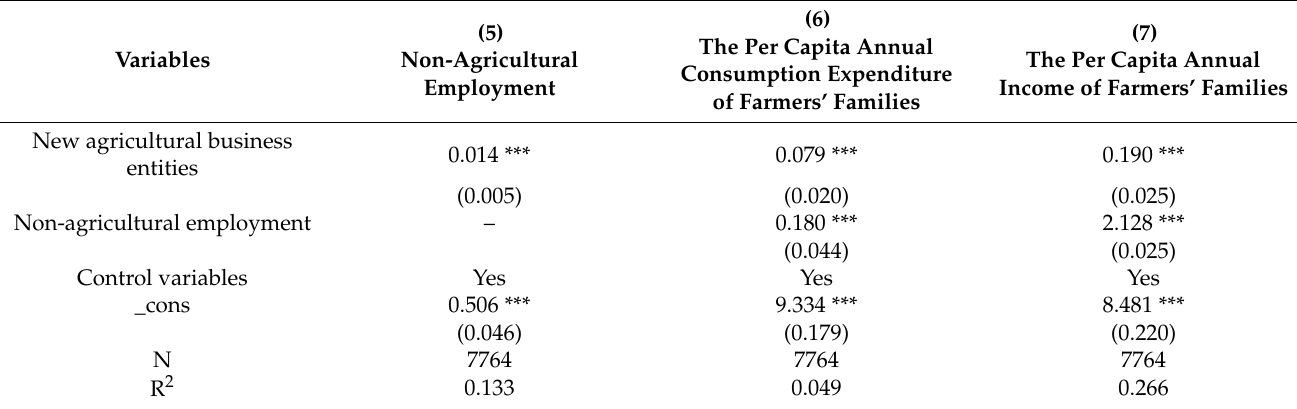
Table 4. Non-agricultural employment plays an intermediary role in the impact of new agricultural business entities on the economic welfare of farmers’